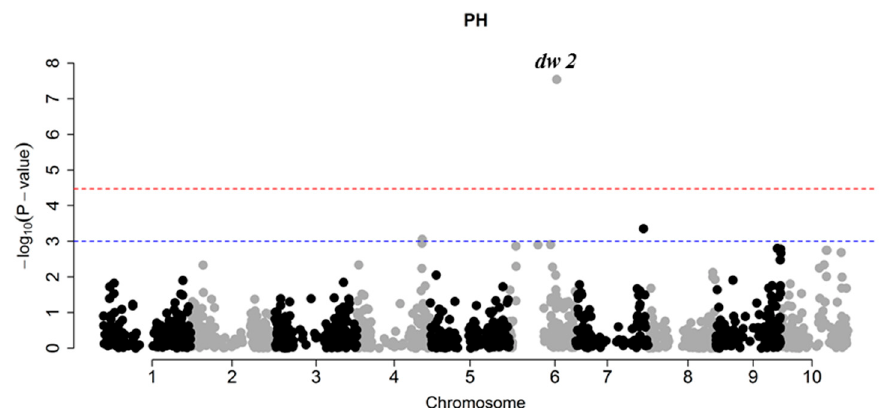
Figure 6. Manhattan plot showing p- values and marker–trait associations for PH. Red and blue horizontal lines indicate thresholds for significant marker–trait associations after Bonferroni correction ( p < 3.32 × 10 − 5 , 0.05/ N ) and weak associations ( p < 1 × 10 − 3 ). The known plant height gene dw 2 is marked in the plot.